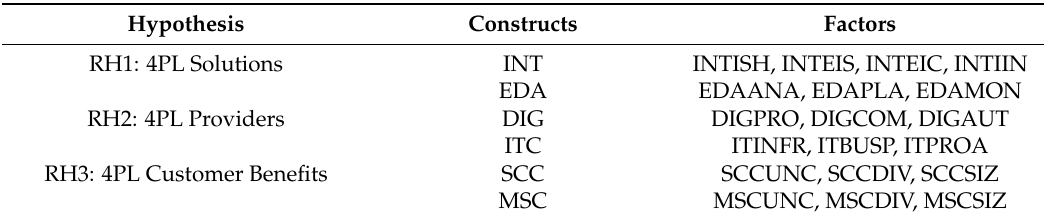
Table 1. Overview of research hypotheses, constructs and factors for the structured online survey. Hypothesis Constructs